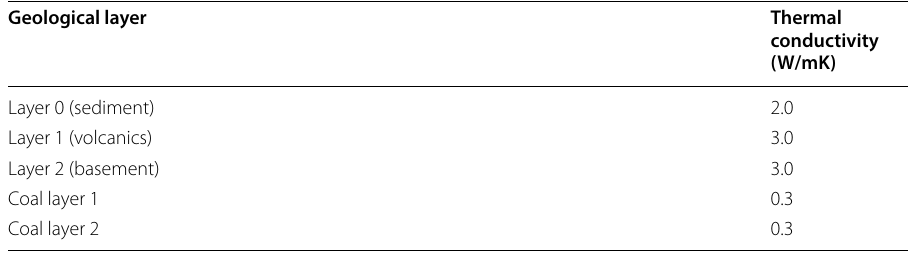
Table 2 Constant thermal conductivity values used for geothermal models Geological